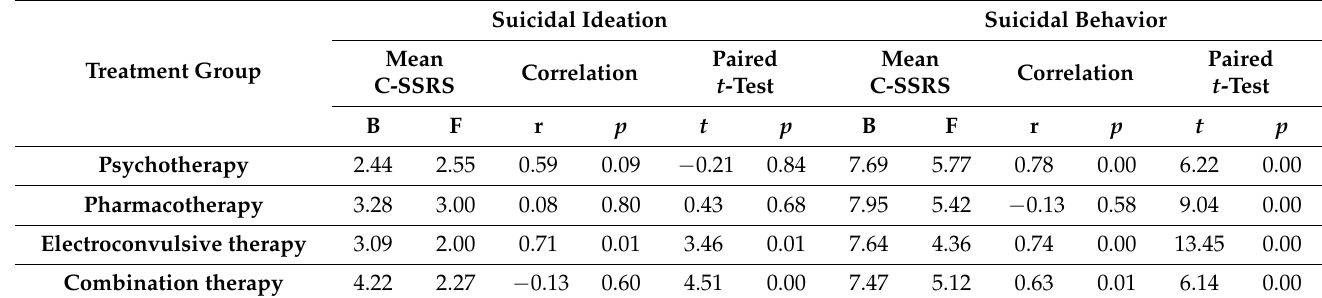
Table 3. Suicidal ideation and behavior. Comparative assessment of treatment efficacy for different treatment modalities through the C-SSR Scale applied at baseline and after the 3-month follow-up in respective group